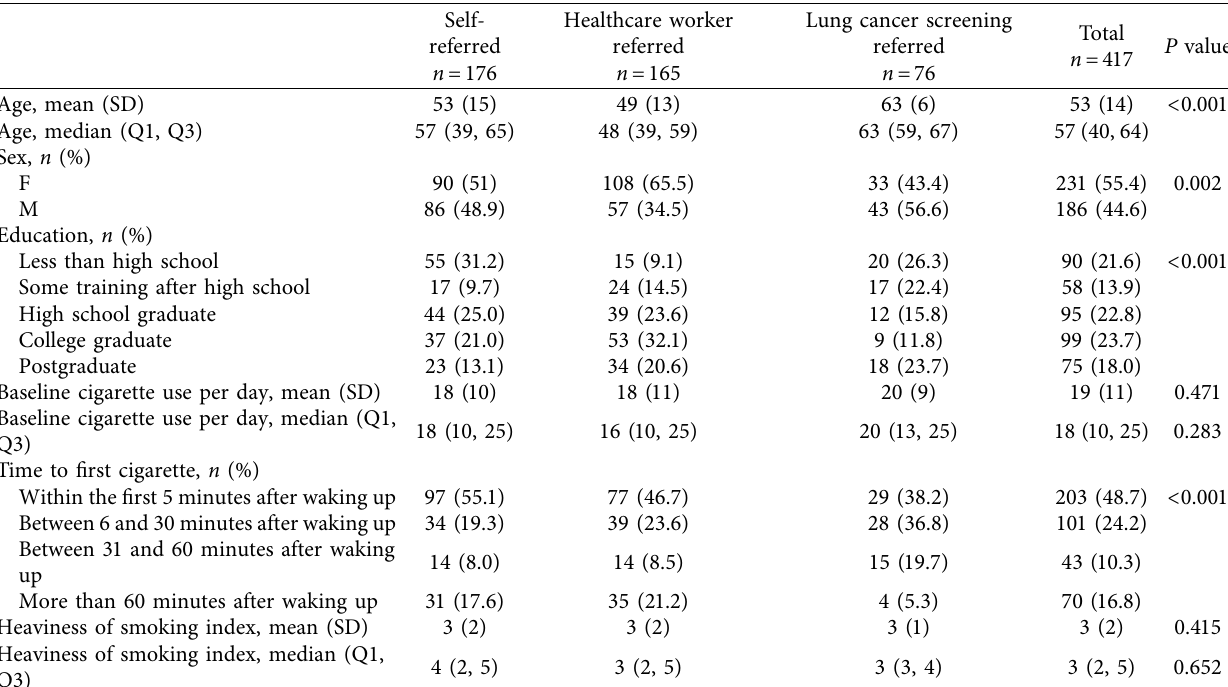
Table 1: Baseline